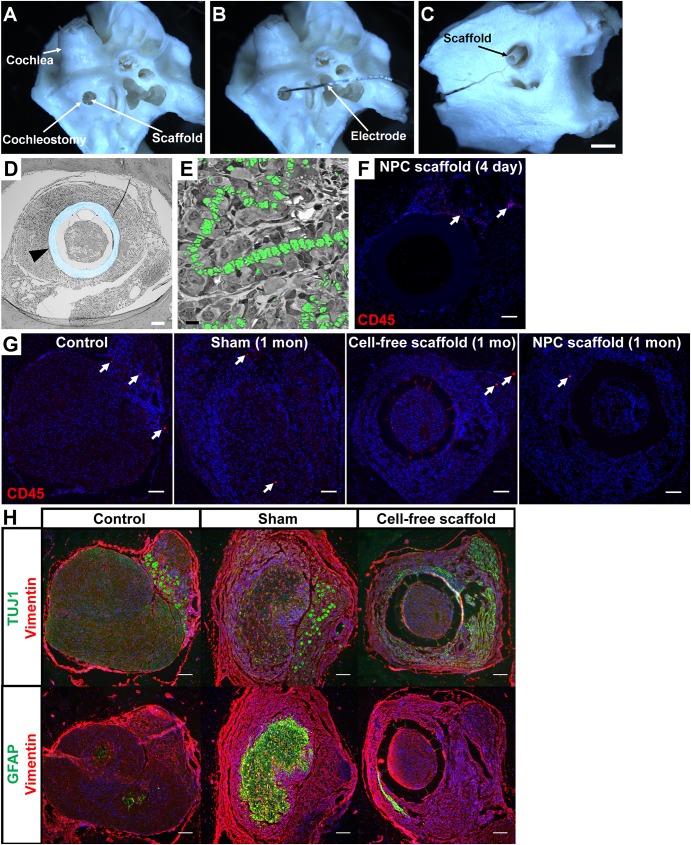
Surgical approach and histological assessment of placement and tissue response.(A–C) Guinea pig temporal bone showing the access to and the scaffold placement in the IAM. (A) The scaffold was advanced into the IAM through a cochleostomy in the base of the cochlea. (B) Positioning of the electrode co-implanted for eABR recordings. (C) View on the positioned scaffold from the brain side. (D and E) Plastic cross-sections of the IAM with implanted cell-free scaffold 15 days post-implantation. (D) Cross section showing the IAM with its bony wall and the scaffold (arrowhead; sheath shaded in blue) embedded in host tissue. Host tissue was found to infiltrate the full length of the scaffold. (E) Higher magnification of the scaffold’s interior with host tissue embedding the nanofibers (shaded in green), which adopt a chain-like arrangement. (F) IAM immunohistochemistry for the hematopoietic lineage marker CD45 shows few immune cells within the IAM 4 days after implantation with an NPC-seeded scaffold. (G) Additional samples 1 month post-implantation were examined for CD45 labeling, including sham, cell-free scaffold, and NPC scaffold animal groups, as well as untreated controls. Few immune-positive cells were identified in these sections indicating that the surgery, scaffolds, and NPCs did not trigger a significant immune response. (H) Immunohistochemistry for TUJ1 (neurons), GFAP (glia) and vimentin (Schwann cells/fibroblasts) in control, sham and cell-free scaffold (1-month post implant) shows involvement of vimentin and GFAP positive cells in tissue repair. Scale bars represent 1 mm in A—C, 100 μm in D—H.